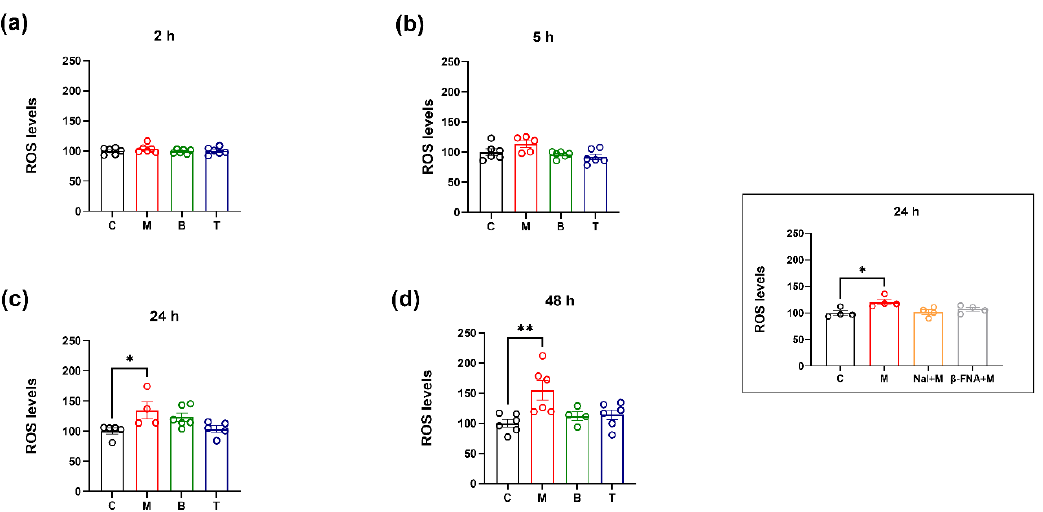
Figure 1. ROS production after treatment with 10 µM morphine (M), 0.25 µM buprenorphine (B) or 10 µM tapentadol (T) in SH-SY5Y cells at different time points ( a – d ). The right framed insert reports ROS production after cotreatment with 10 μM naloxone (Nal) + 10 μM morphine (M) or 10 μM β - funaltrexamine (β -FNA) + 10 µM morphine (M) in SH-SY5Y cells at 24 h. Data, reported as the mean ± SEM of four/six biological replicates for each treatment, are expressed as the percentage of relative fluorescence ( a – d ) or the percentage of the intensity of the first spectra line (insert) compared to control (C) and are analyzed by one- way ANOVA followed by Dunnett’s multiple comparison s test (* p < 0.05; ** p < 0.01 vs. control).